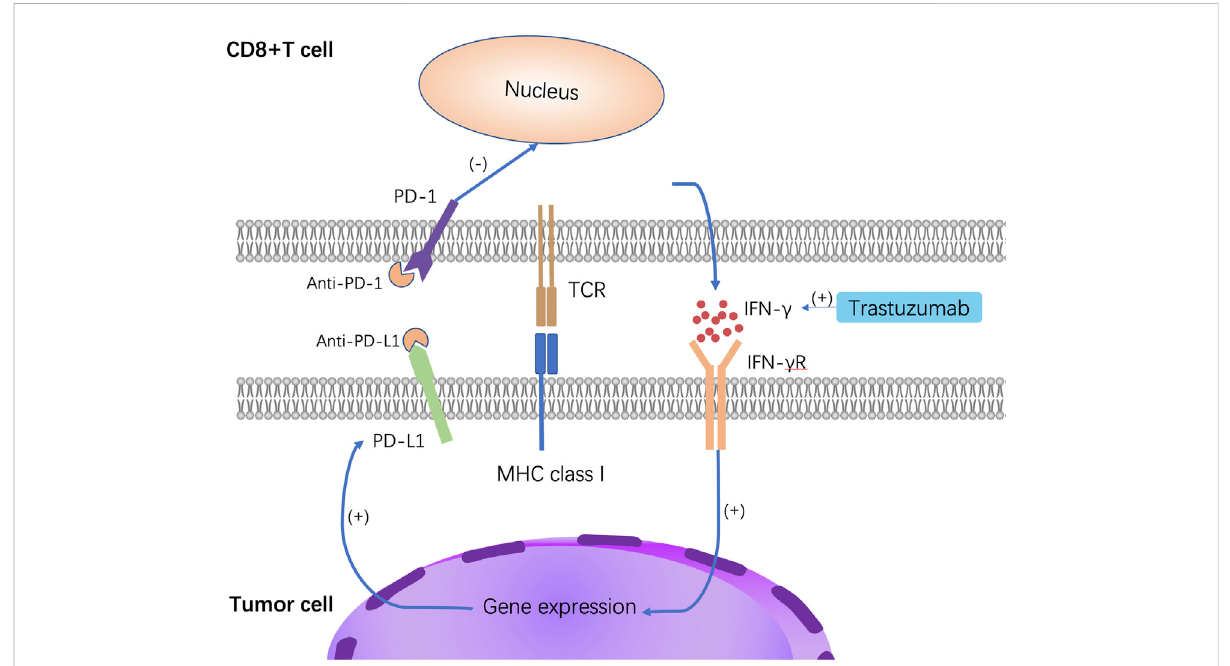
FIGURE 3 Mechanismofanti-PD-L1therapy.Afterinterferonexposure,tumorcellsreactivelyexpressPD-L1,whichbindstoPD-1onthesurfaceofTcells and inhibits T cells. Anti-PD-1 or anti-PD-L1 antibodies can block the interaction of PD-1 with PD-L1 and reverse the inhibition of CD8 + T cells, thereby enhancing anti-tumor activity.